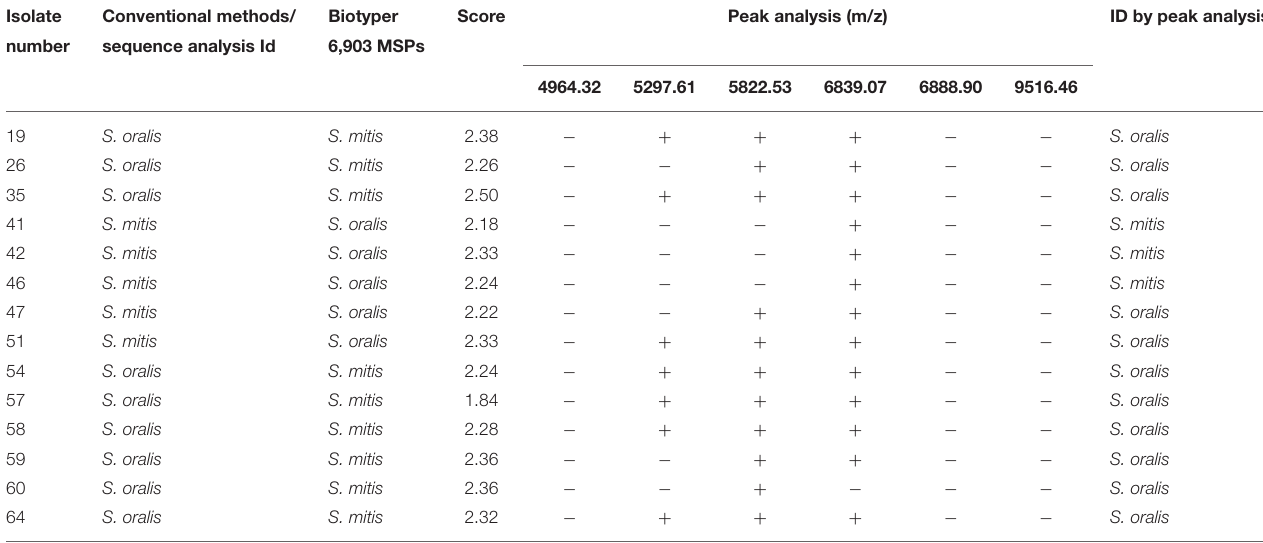
TABLE 3 | Reidentification by peak-analysis of SMG isolates that showed discrepancies in the species assignment by MALDI-TOF and the conventional or the molecular methods. Isolate Conventional methods/ Biotyper Score Peak analysis (m/z) ID by peak